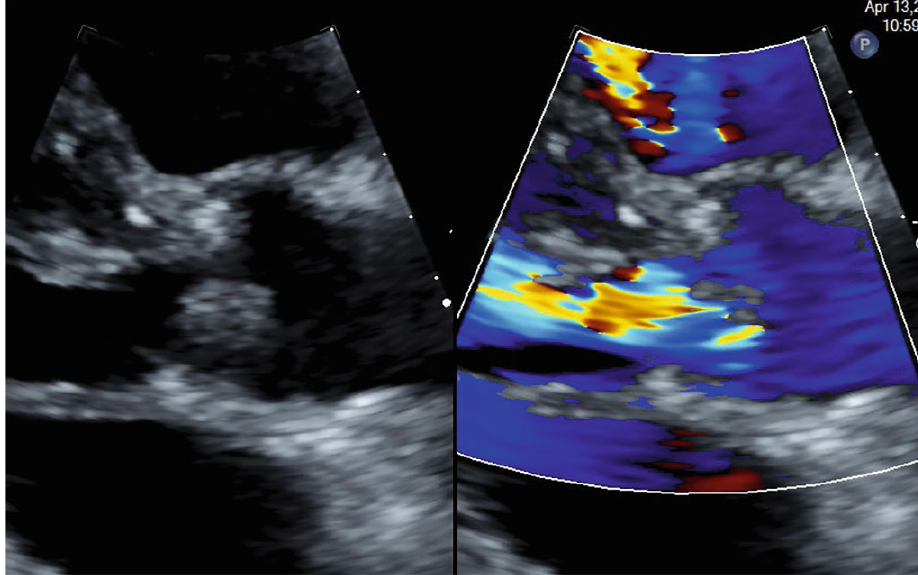
Figure 1: TTE from parasternal long axis view showing large echodensity on the right coronary cusp. Color Doppler demonstrates